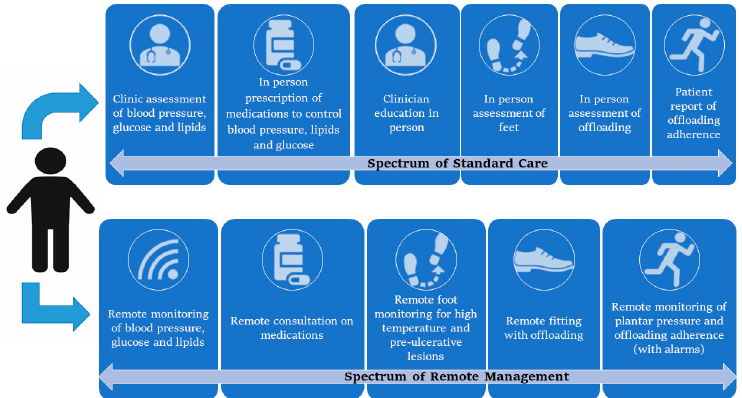
Legend: The table outlines the risk factors for the development of diabetes-related foot disease and how sensors and wearables could be used to remotely monitor these factors. References are provided for the relevant research articles assessing the impact or implementation of such technologies for further reading.